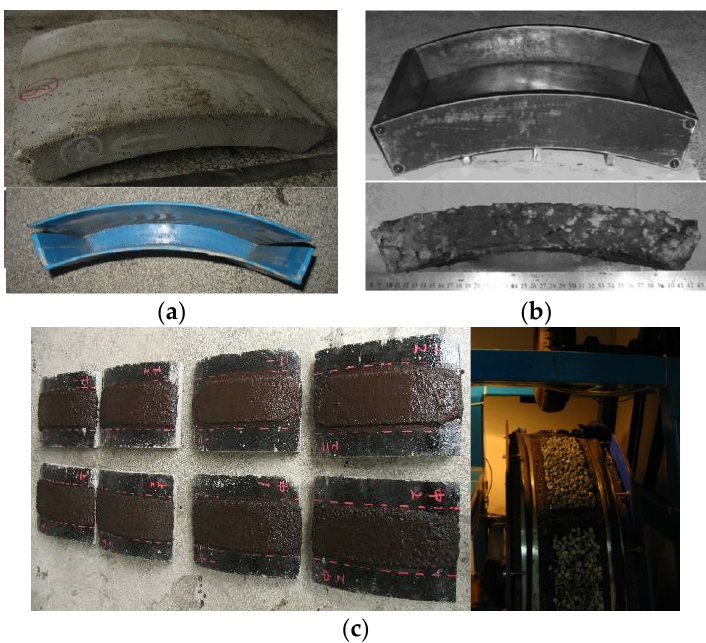
Figure 3. The three types of accelerating test specimens: ( a ) cement concrete specimen, ( b ) asphalt concrete specimen, and ( c ) functional layer specimen.